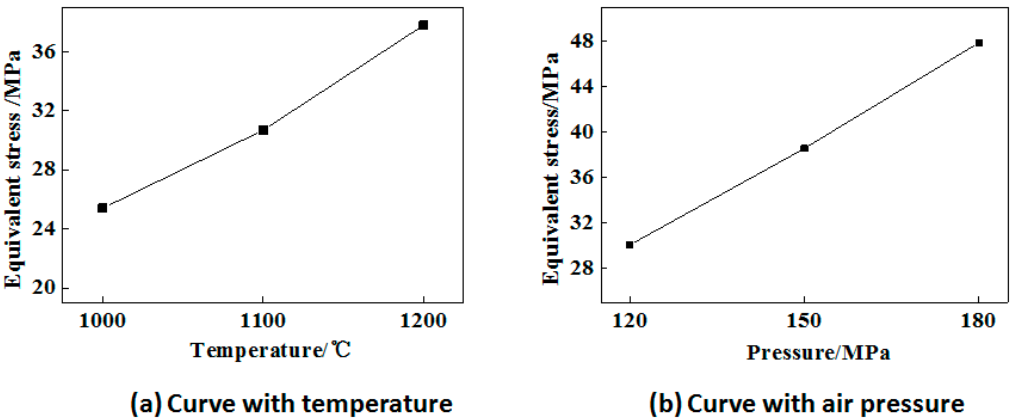
Figure 11. The curve of equivalent stress of steel ball core in terms of changing temperature and air pressure. ( a ) Curve with temperature; ( b ) Curve with air pressure.